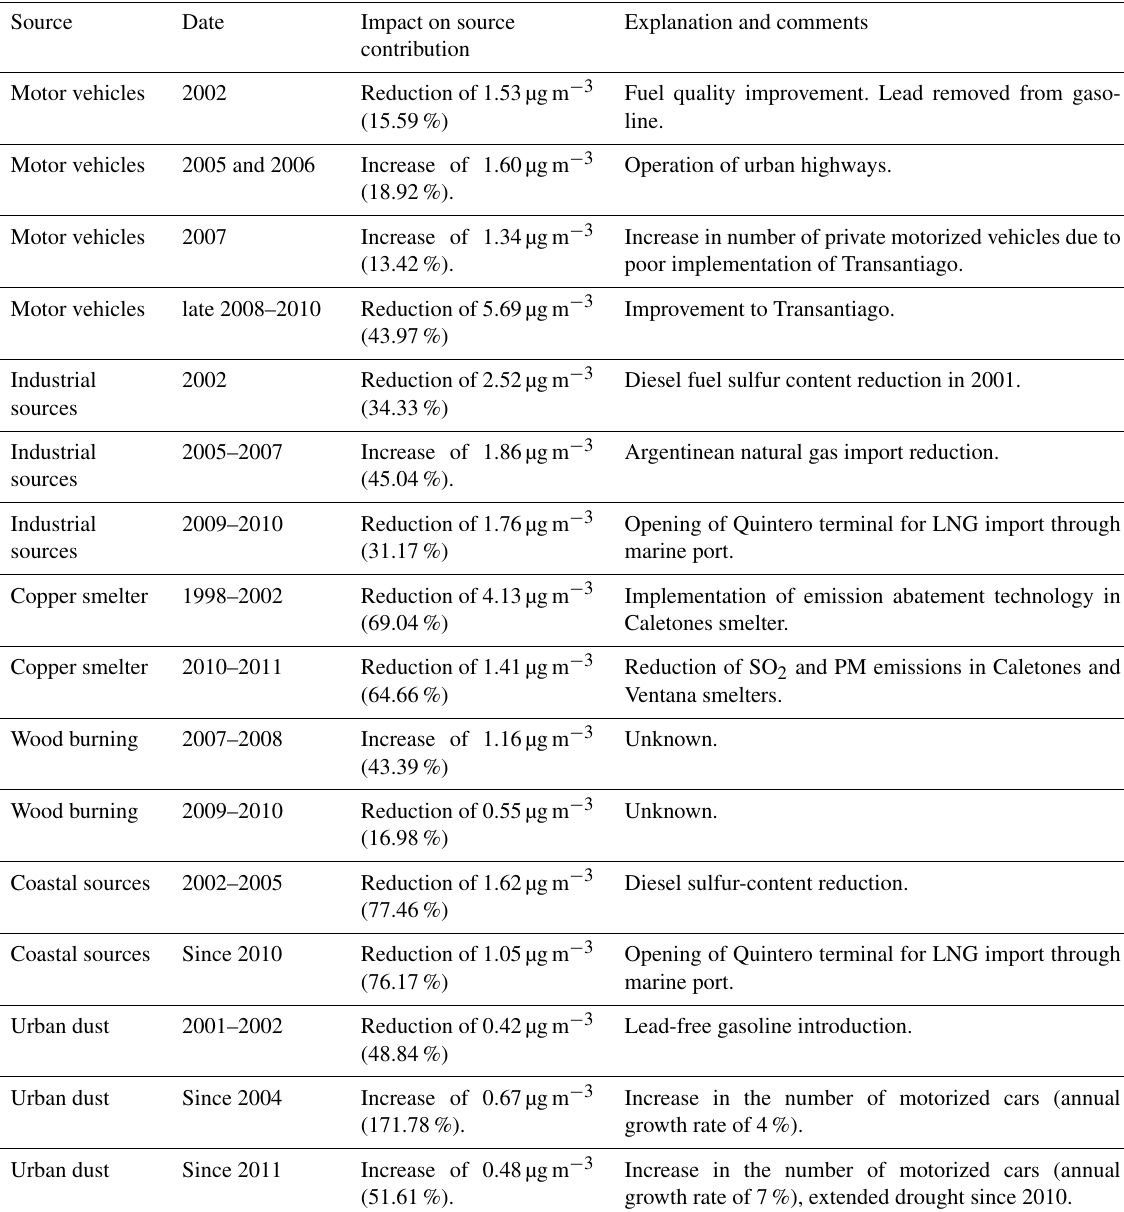
Table 4. Significant changes in PM 2 . 5 sources in context with Santiago air quality improvement measures taken at that